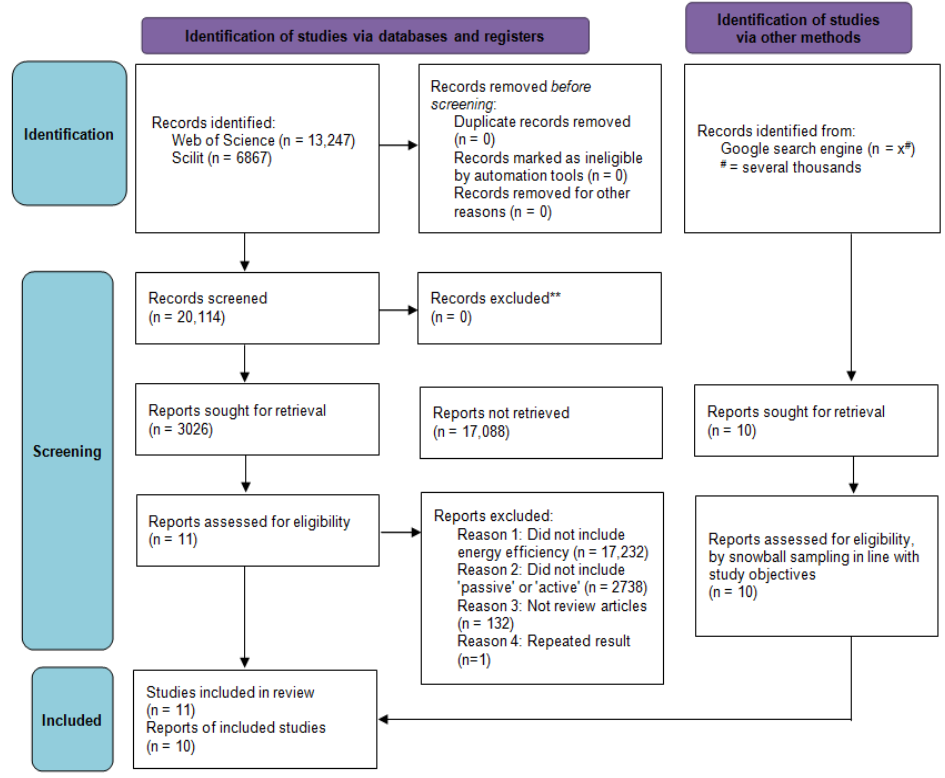
Figure 2. PRISMA 2020 flow diagram for new systematic reviews (adapted from Page et al., 2020 [27]).